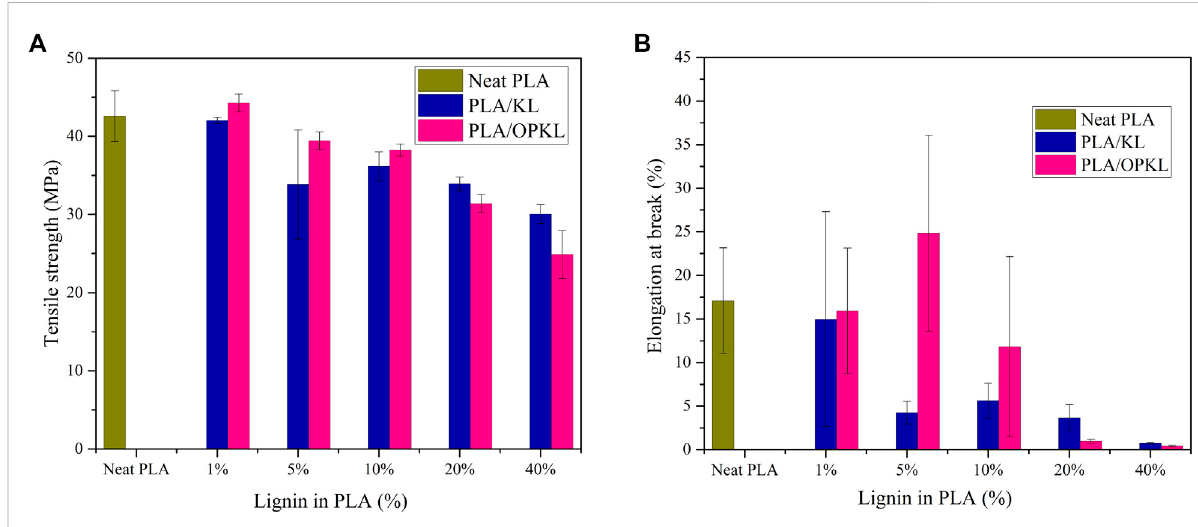
FIGURE 5 Mechanical properties of KL/PLA and PLA/OPKL, (A) Tensile strength, and (B) Elongation at break.